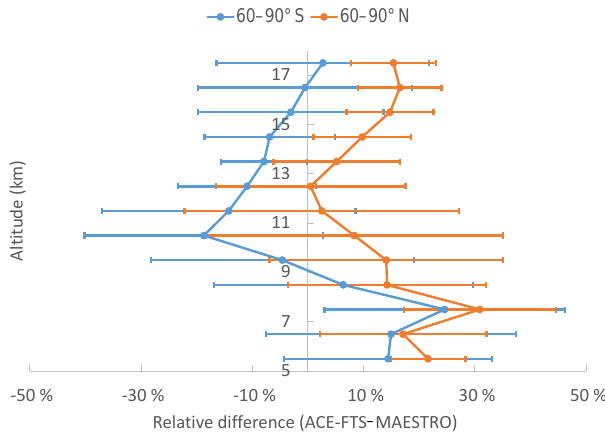
Figure 1. (Orange) Relative differences between ACE-FTS and MAESTRO climatological medians averaged over the 8 months of sampling the northern high-latitude region and their standard devia- tion; (blue) relative differences between ACE-FTS and MAESTRO climatological means averaged over the 8 months of sampling the southern high-latitude region and their standard deviation. The hor- izontal bars show the standard deviation of the differences between the two climatologies over the 8 available months. To account for vertical resolution differences, the MAESTRO climatology was ver- tically smoothed with a 3km